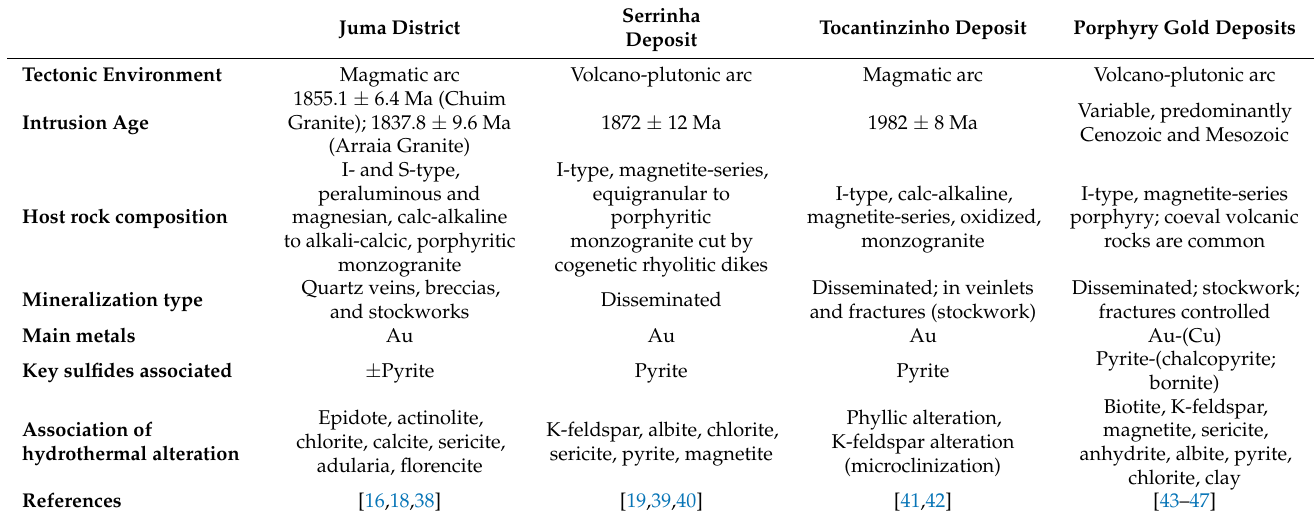
Table 1. Key characteristics of the Juma District Orosirian gold deposits compared to the Serrinha, Tocantinzinho, and porphyry gold deposits (Adapted from